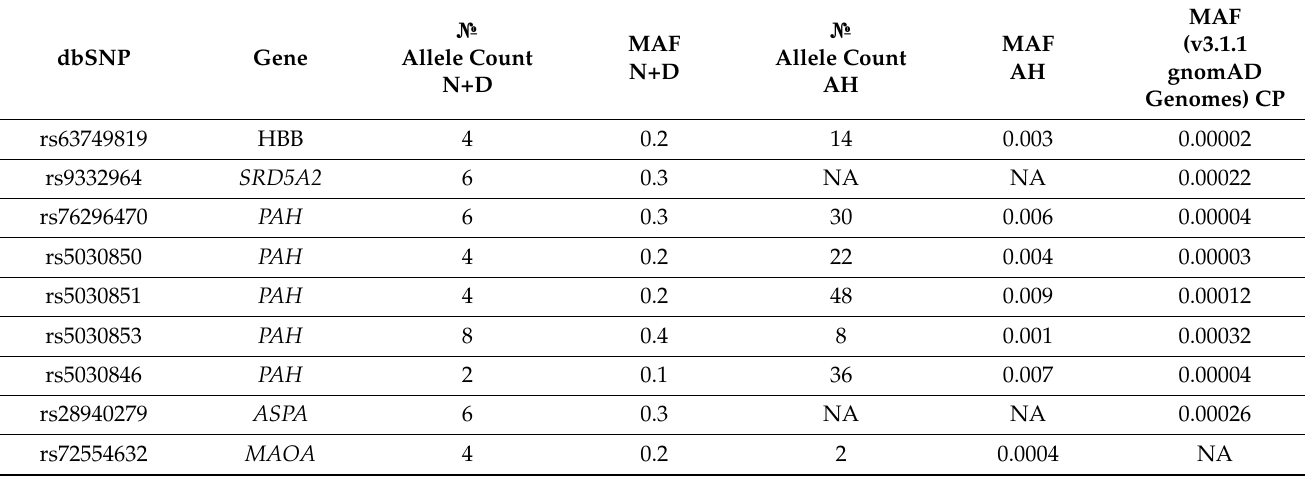
Table 3. Estimated frequencies of pathogenic variants in ancient and contemporary populations. The frequencies in AMH ancient populations are taken from Toncheva et. al., 2022 [39], and those in contemporary populations from GnomAD, v3.1.1